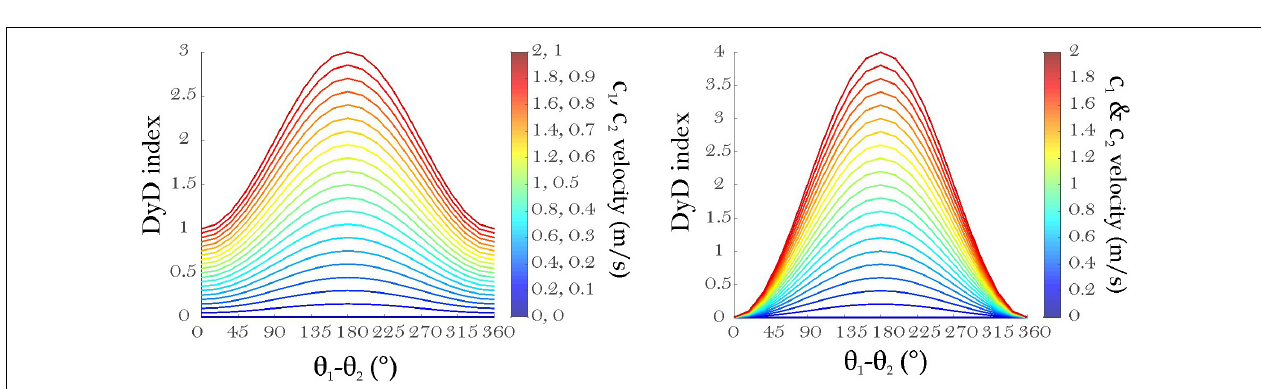
FIGURE 10 | Circulation patterns for the Prot45 RMB case with a selection of wave heights, directions, and river discharges. Values in left bottom corner of each plot show the Q Jet / Q LSC ratio.